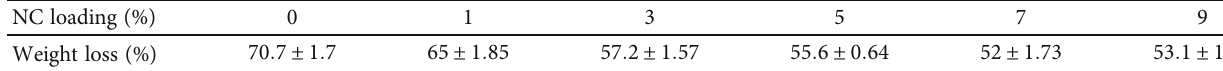
Table 3: Weight loss of neat PVA and composite fi lms at di ff erent NC loadings after 90 days.